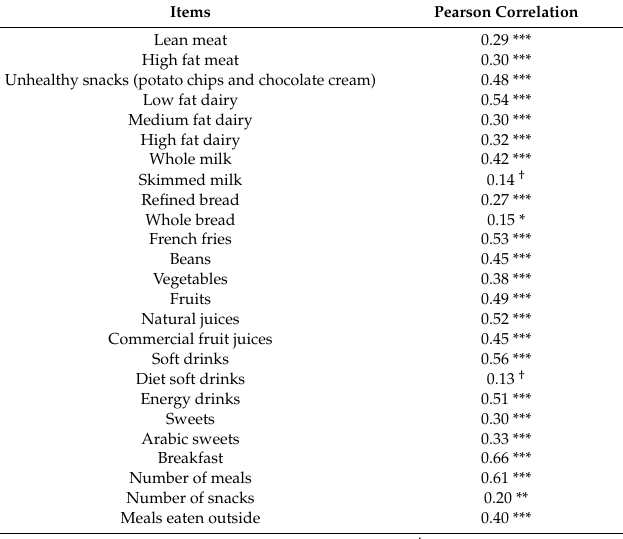
Table A11. Pearson’s correlations between the DAQ items and the corresponding items based on the 24 h